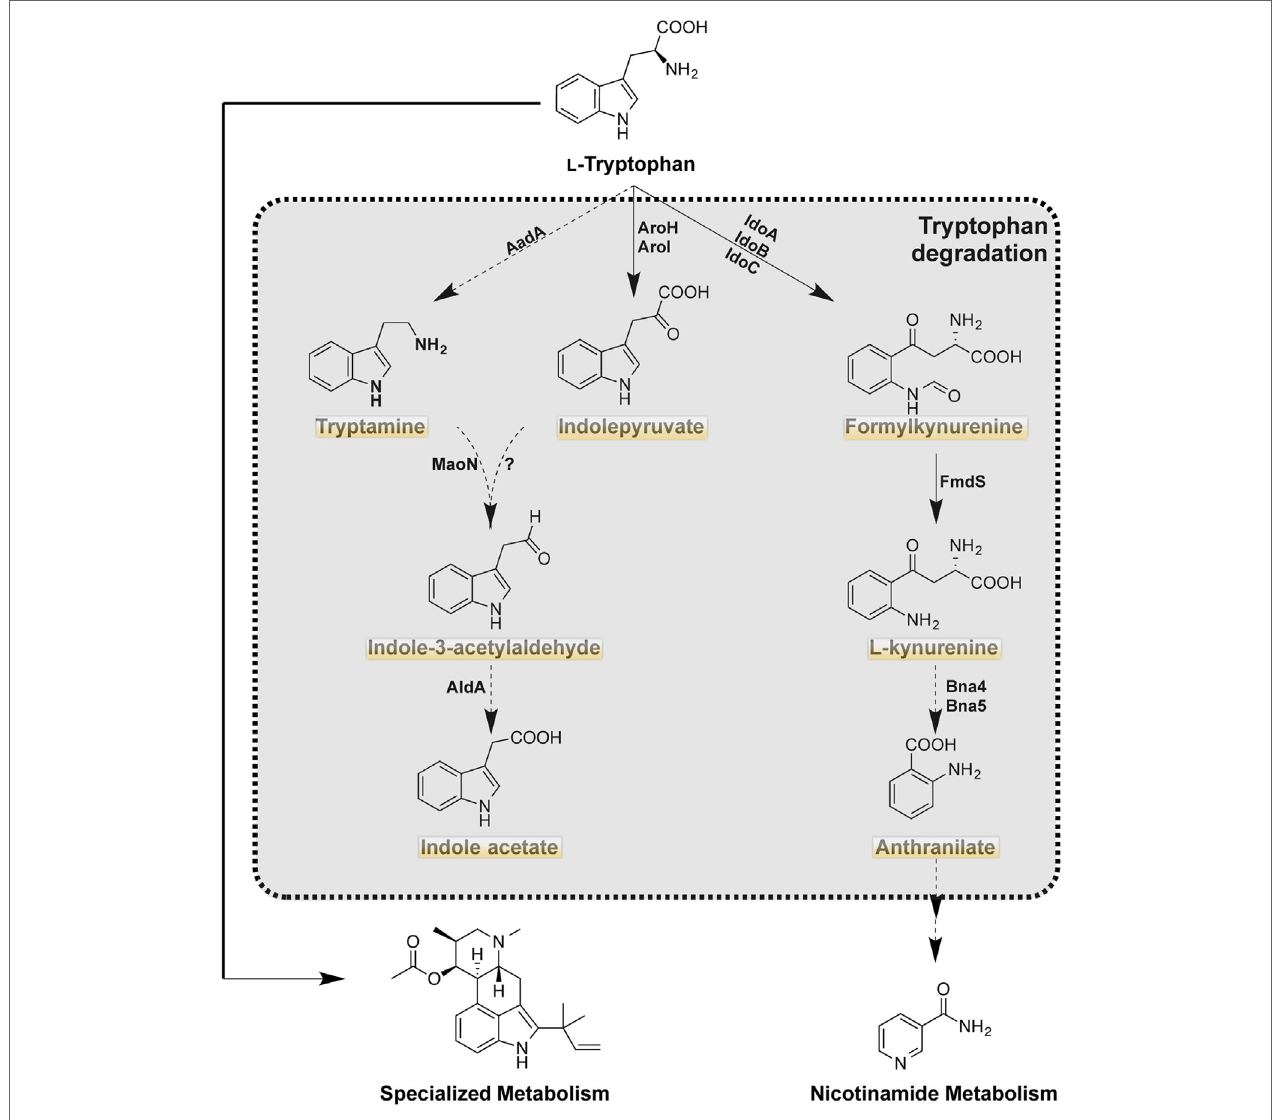
FiGURe 2 | Tryptophan catabolism of Aspergillus fumigatus. Highlighted products are putatively produced in the mammalian host as the orthologous enzymes are present in the host (http://www.genome.jp/kegg). Solid arrows indicate characterized reaction as being present in A. fumigatus with product detected. Dashed arrows indicate uncharacterized reactions, however putative orthologs are present in A.